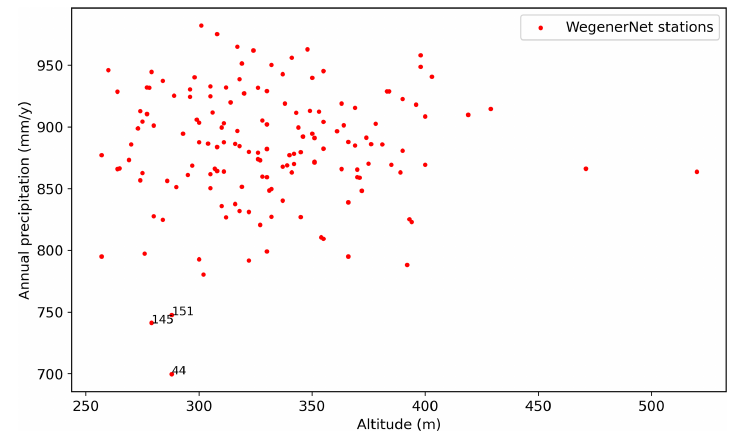
Figure B2. Annual precipitation for each WegenerNet station and its corresponding